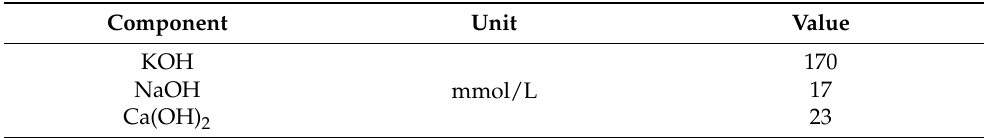
Table 5. Initial composition of synthetical pore